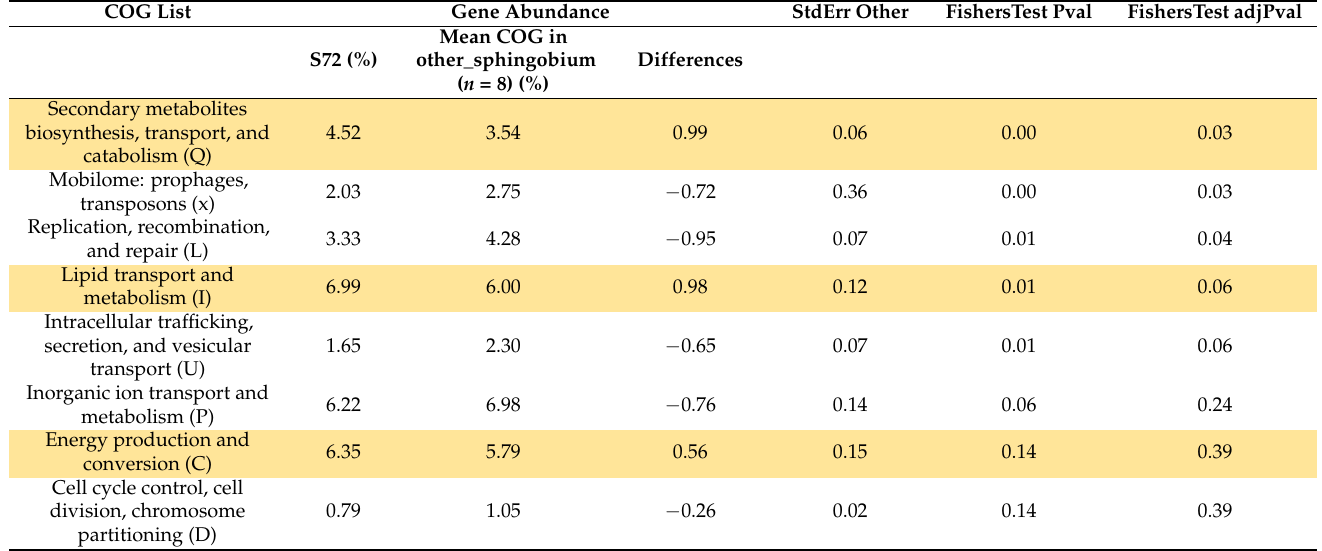
Table 3. COG comparison between S72 and other Sphingobium yanoikuyae recovered from the IMG